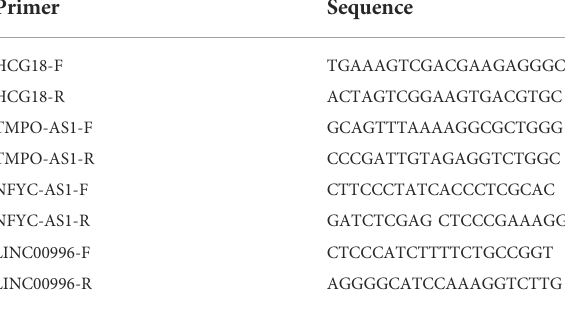
TABLE 1 Primers for the detection of lncRNAs expression in LUAD specimens.